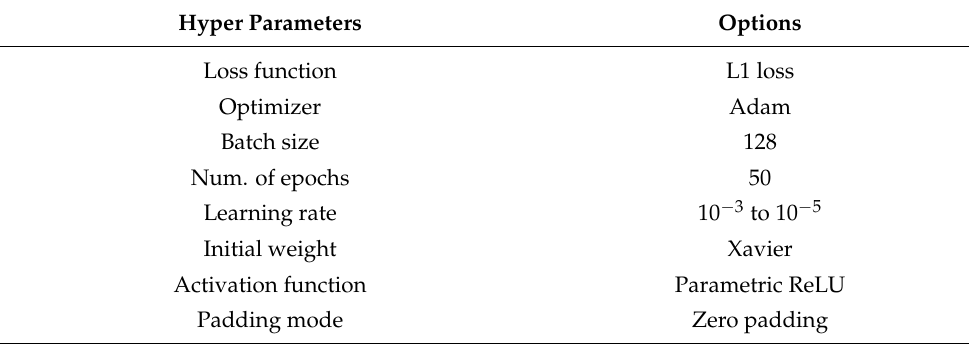
Table 1. Hyper parameters of the proposed